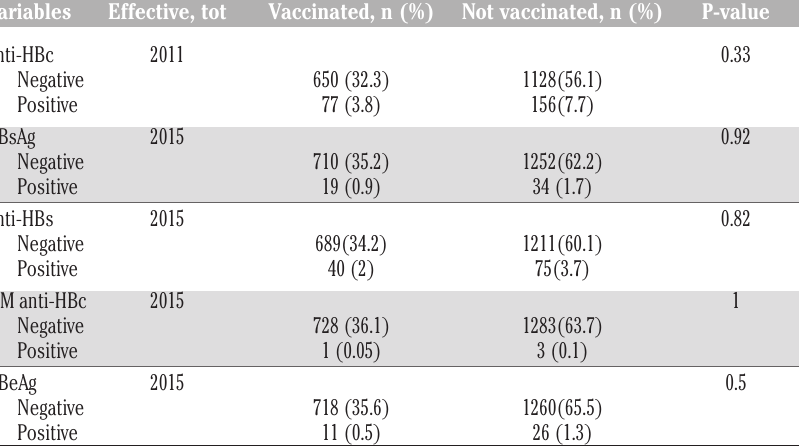
Table 2. Impact of the vaccine on the carriage of different markers of HBV.